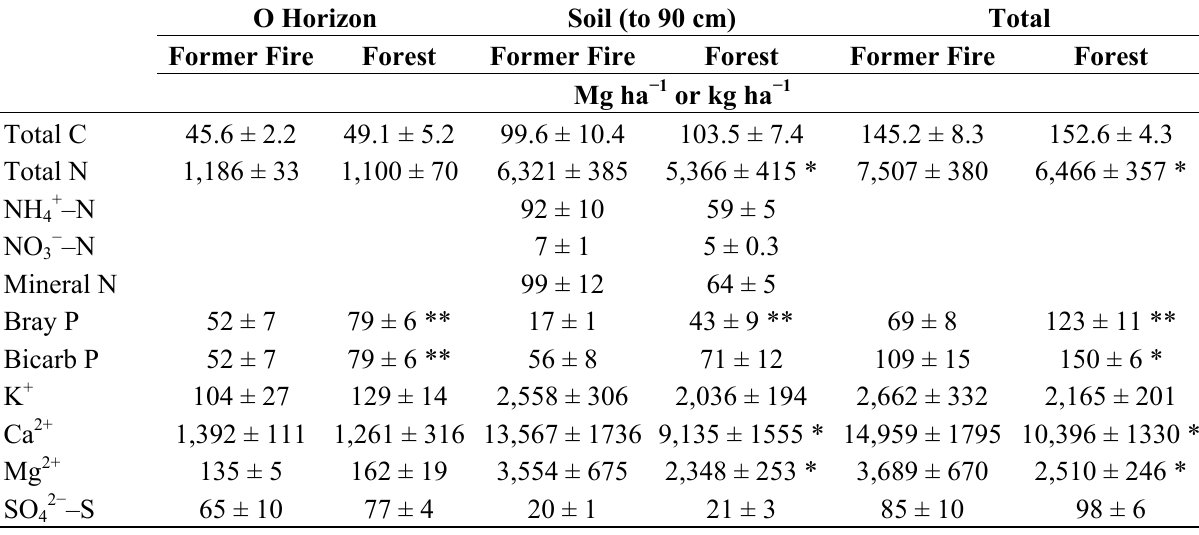
Table 3. Carbon and nutrient contents of O horizons and soils in adjacent previously former fire (Fire in 1961) and unburned forested sites at Sagehen, California. Mg ha − 1 for C, kg ha − 1 for nutrients. Contents of K, Ca, and Mg in soils represent exchangeable values and contents of S in soils represent extractable values. Standard errors are